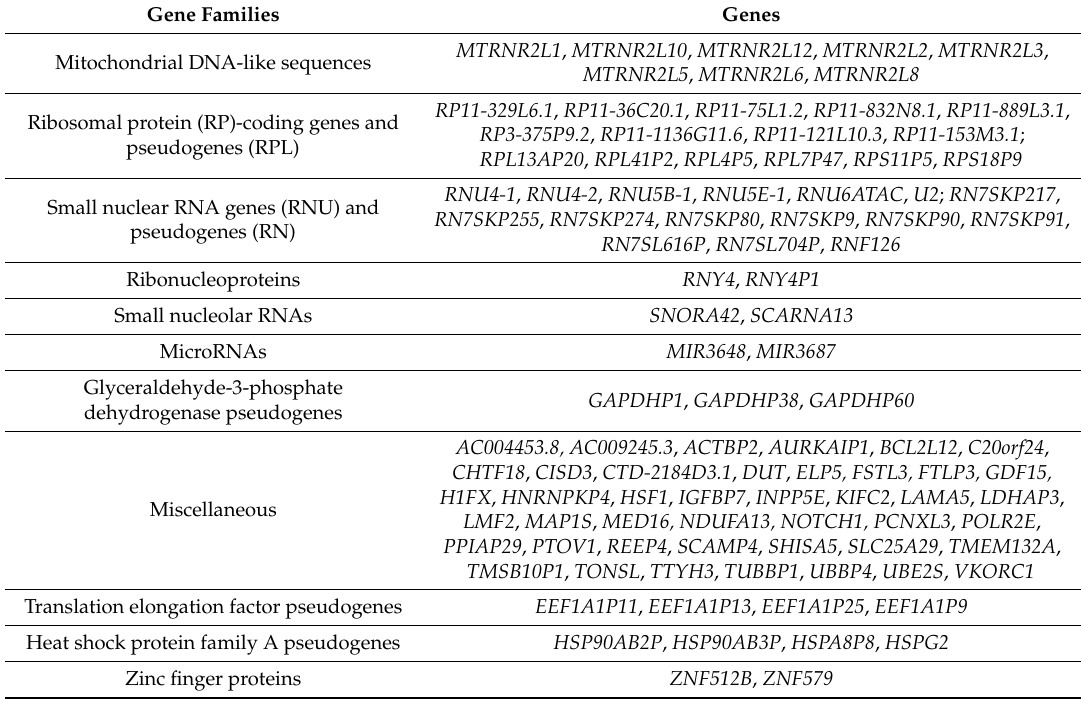
Table 3. Overlapping genes downregulated by sofosbuvir and upregulated by daclatasvir in SNU449. Gene Families